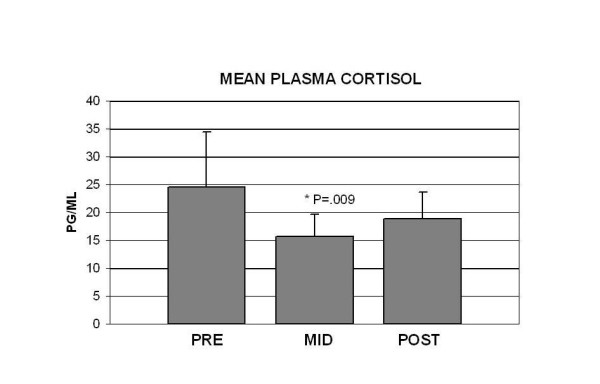
Mean pre-, mid-, and post-mission plasma cortisol levels for the HMP-2002 study participants.